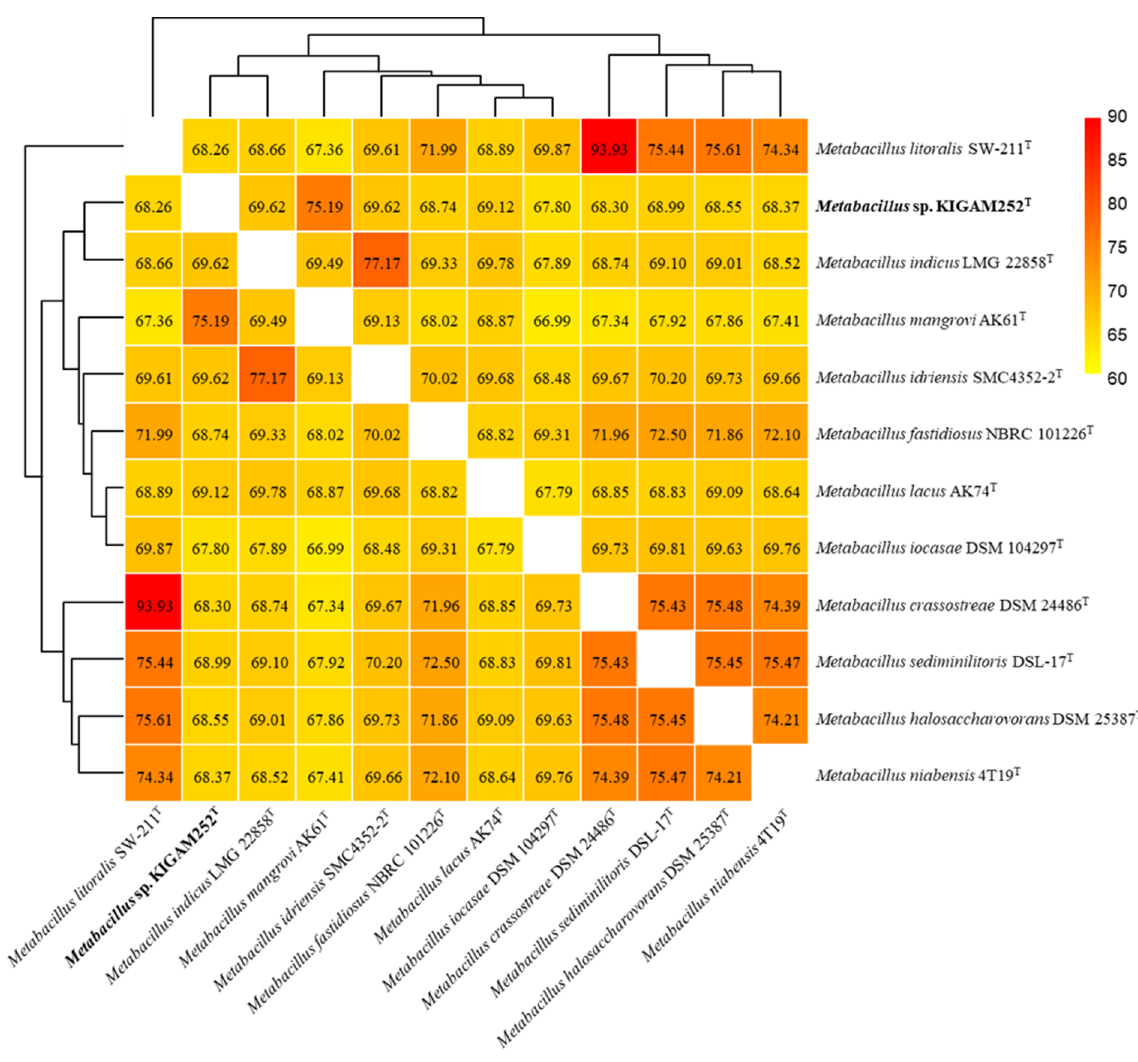
Figure 2. Heatmap based on OrthoANI values calculated for strain KIGAM252 T and other species of the genus Metabacillus ; M. mangrovi AK61 T , M. indicus LMG 22858 T , M. idriensis SMC4352-2 T , M. lacus AK74 T , M. sediminilitoris DSL-17 T , M. fastidiosus NBRC 101226 T , M. halosaccharovorans DSM 25387 T , M. niabensis 4T19 T , M. crassostreae DSM 24486 T , M. litoralis SW-2211 T , and M. iocasae DSM 104297 T . High OrthoANI value is indicated in red, whereas lower values are indicated in yellow.